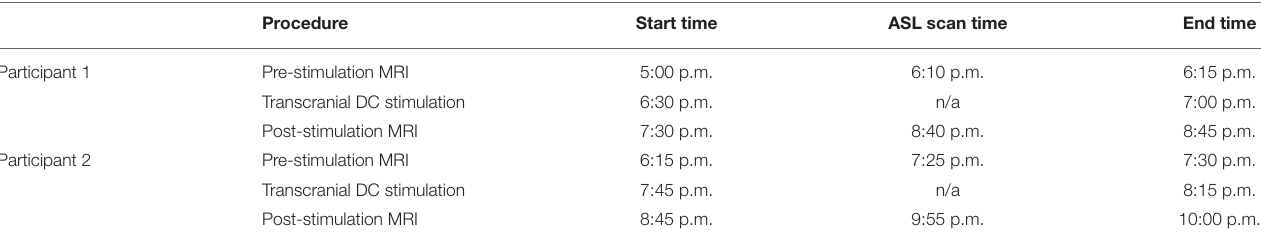
TABLE 1 | Starting times for the experimental